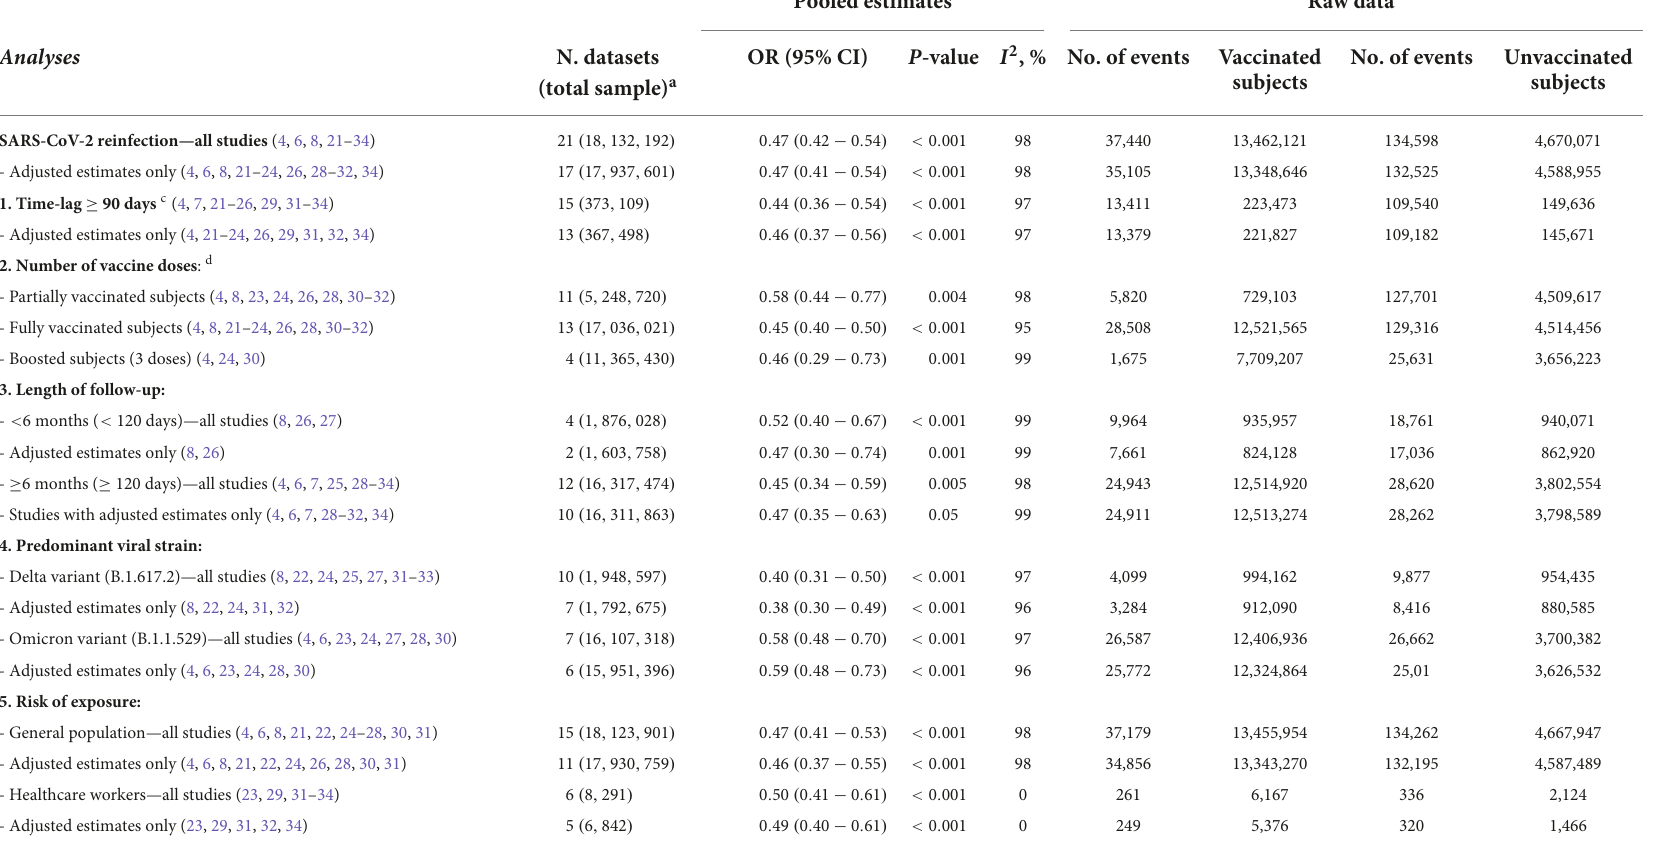
TABLE 3 Risk of SARS-CoV-2 reinfection and severe/critical COVID-19 among vaccinated vs. unvaccinated subjects, overall, and stratified by definition of reinfection, number of vaccine doses, length of follow-up, predominant strain, study design and risk